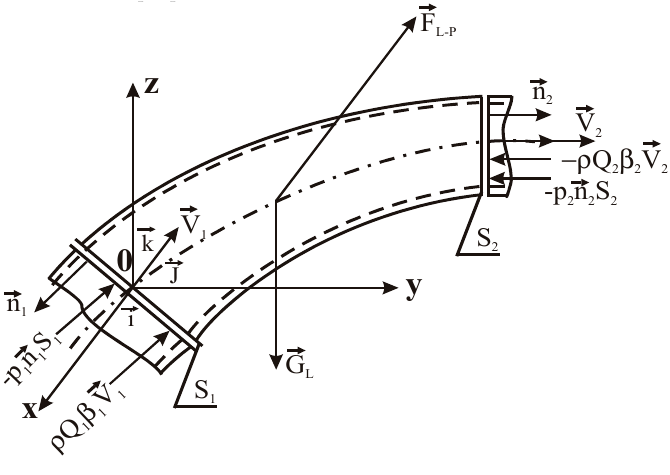
Figure 13. Pipe elbow in a horizontal plane [31].